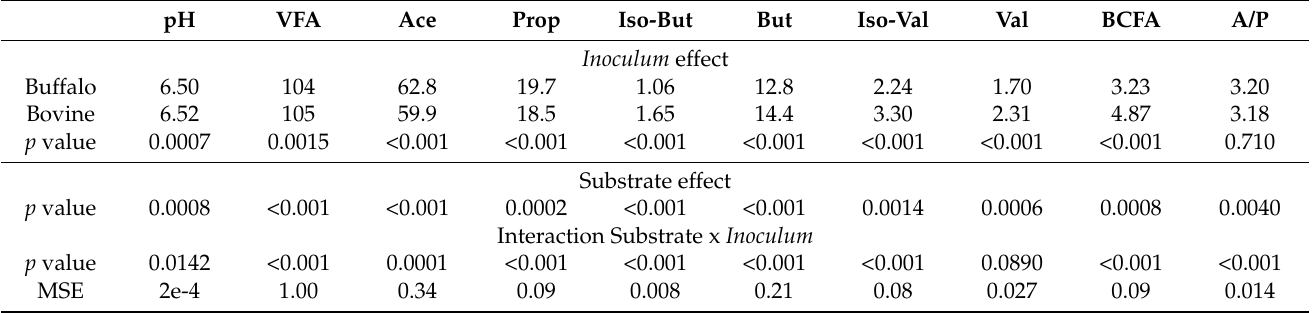
Table 8. Least square means for in vitro fermentation end products (% VFA) evaluated after 120 h of